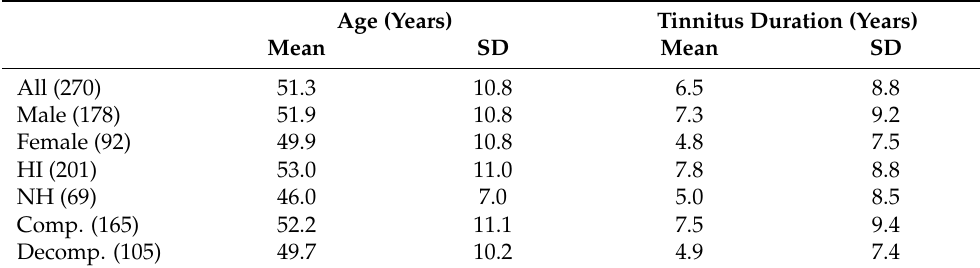
Table 3. Age and tinnitus duration of participants.